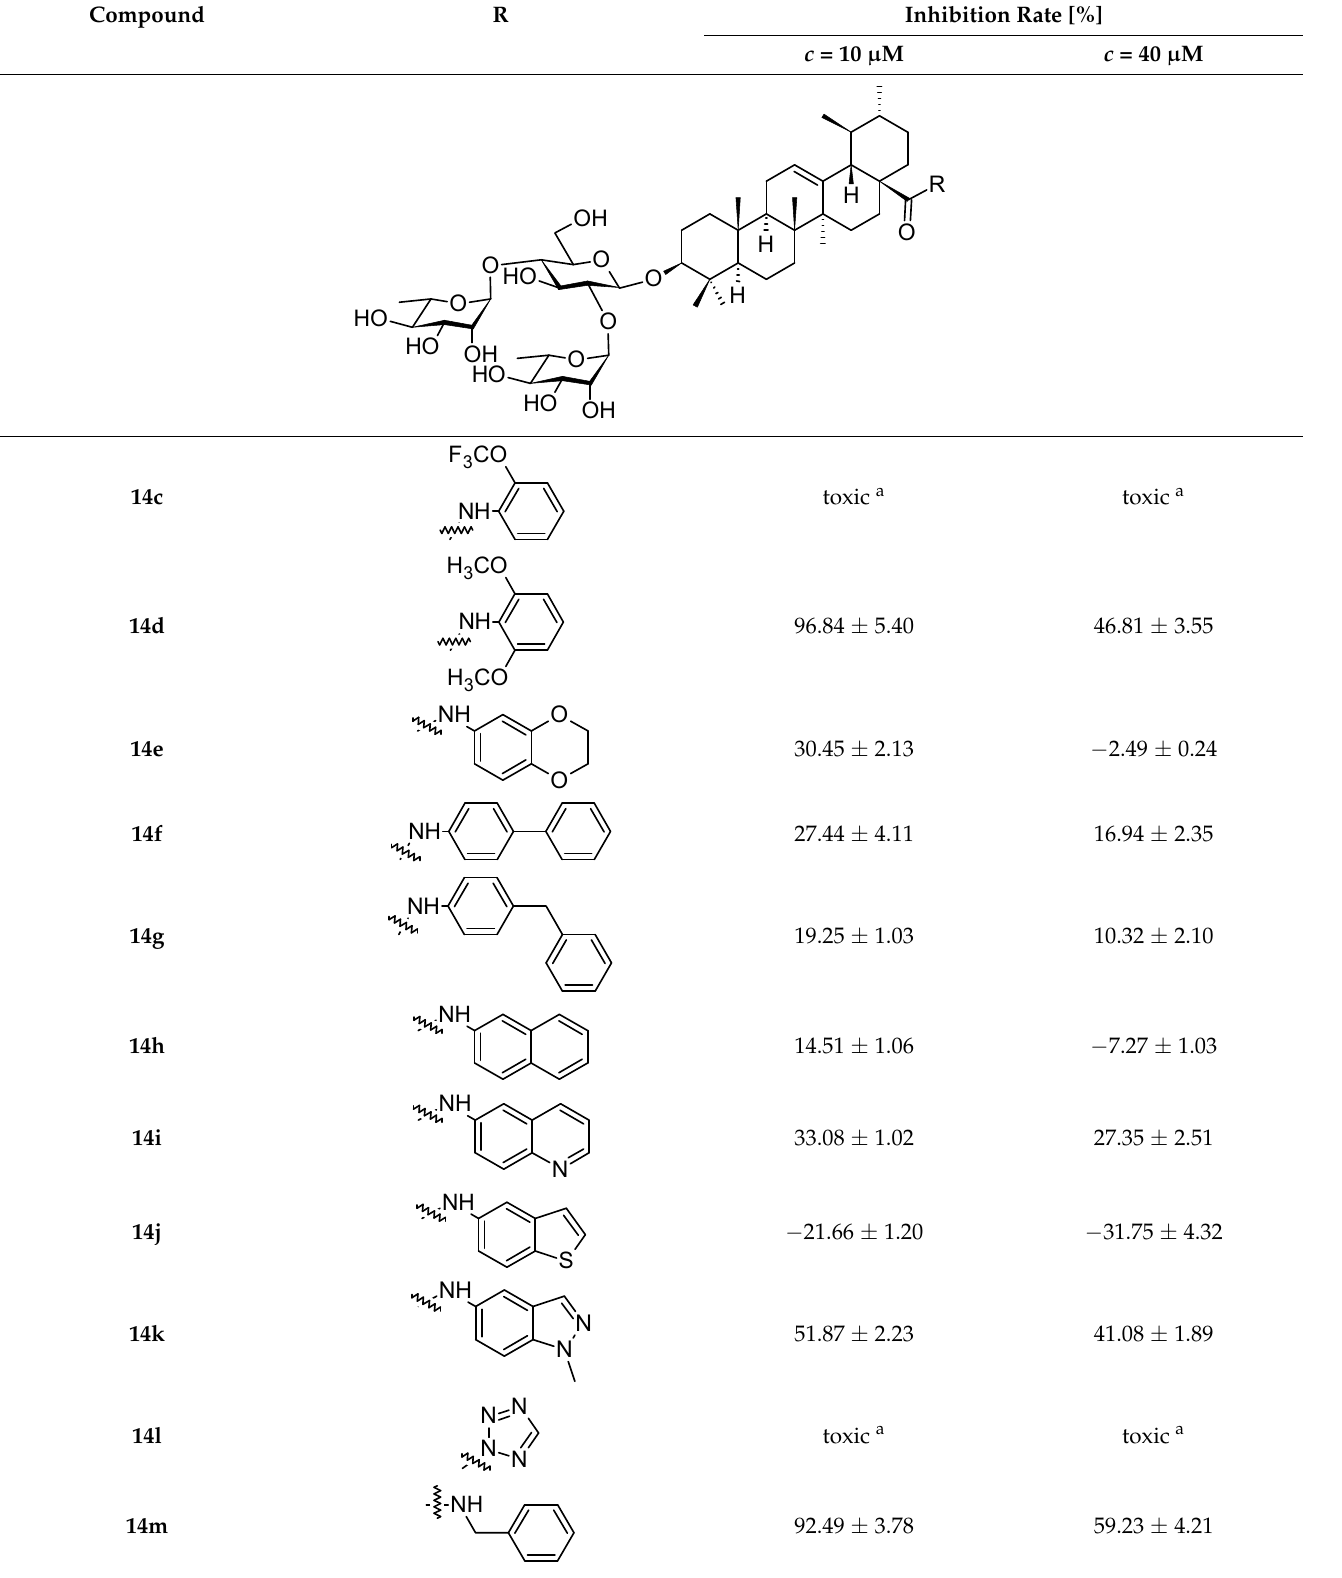
Table 3. Antiviral activity of the saponins 14c – 14q tested in SARS-CoV-2 S protein at the concentra- tions of c = 10 µ M and c = 40 µ M, respectively [72].